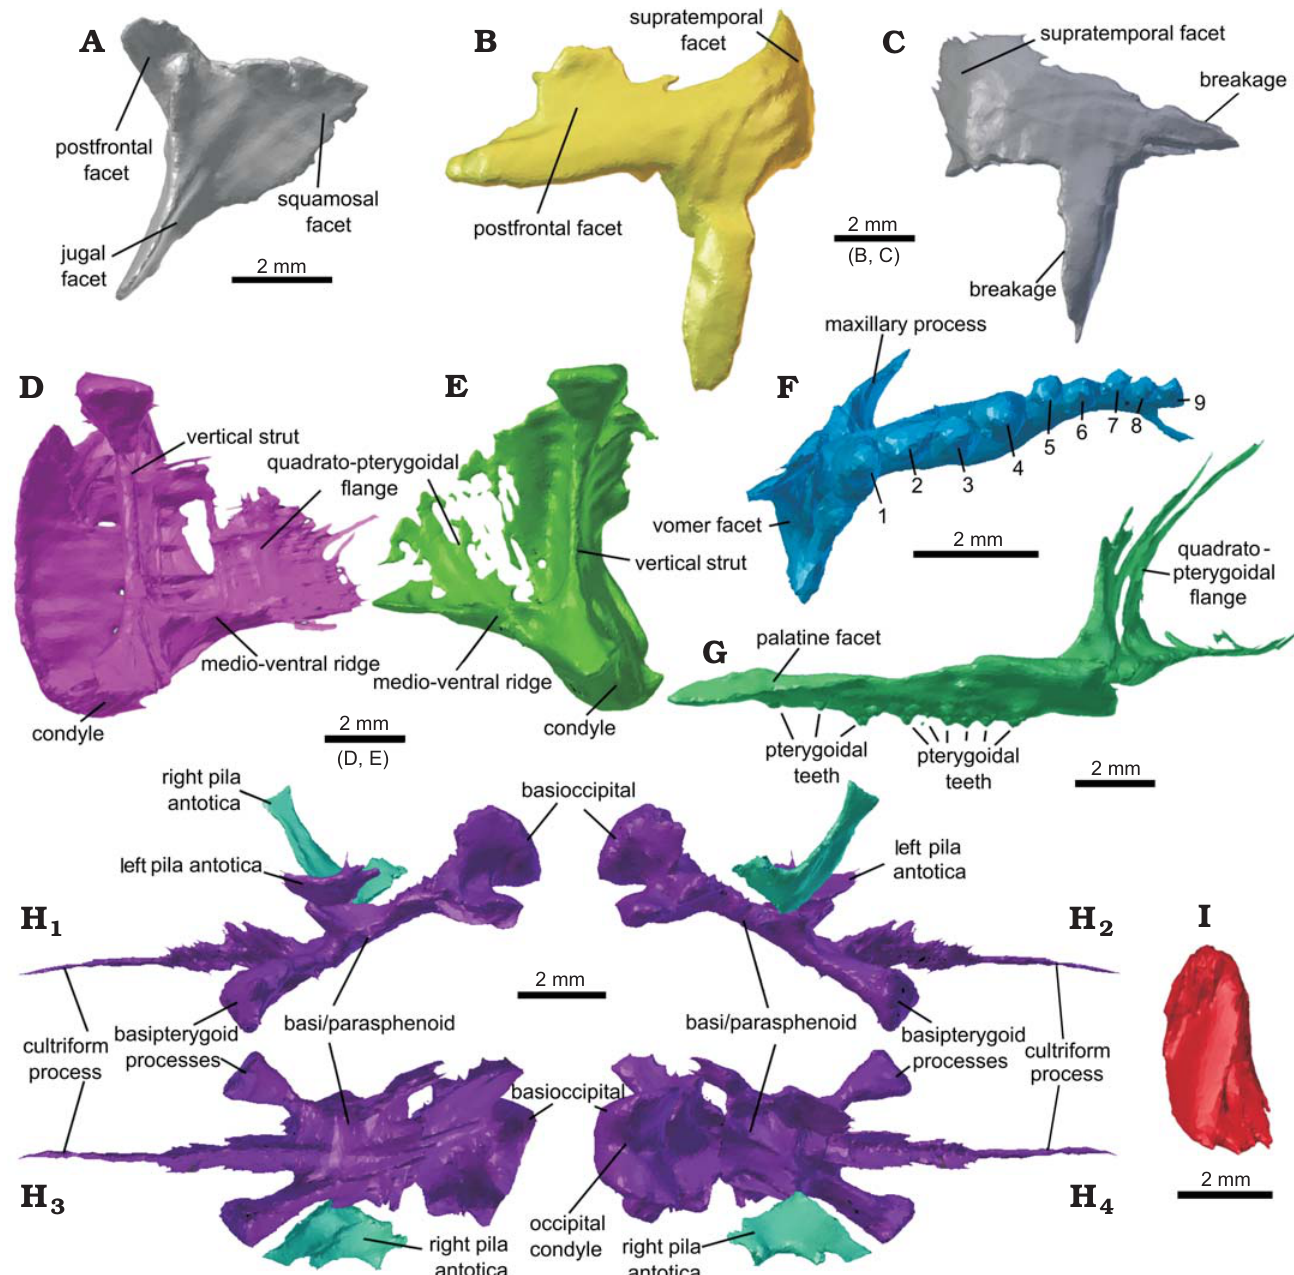
Fig. 2. Newly identified cranial bones present in lepidosaur rhynchocephalian Clevosaurus hudsoni Swinton, 1939 (NHMUK PV R36832) from Rhaetian, Cromhall Quarry, England, UK. A . The right postorbital in medial view, identified from amongst unidentified bones from the original surface dataset created by O’Brien et al. (2018). B . The left squamosal in lateral view, re-identified here from its previous suggested identity of a pterygoid flange. C . The right squamosal in lateral view, like A identified here from amongst previously unidentified bones from the original dataset. D . The left quadrate in medial view, partially resegmented from the original dataset to be more complete. E . The right quadrate in medial view, newly segmented and identified here. F . Left palatine in ventral view, partially resegmented from the original data set, note the number of palatine teeth (nine). G . The right pterygoid in medial view, partially resegmented from the original dataset, seen here with a newly segmented pterygoid flange. H . The newly identified pila antotica, and newly segmented para- and basisphenoids in left (H 1 ) and right (H 2 ) lateral; ventral (H 3 ), and dorsal (H 4 ) views. I . The left coronoid in medial